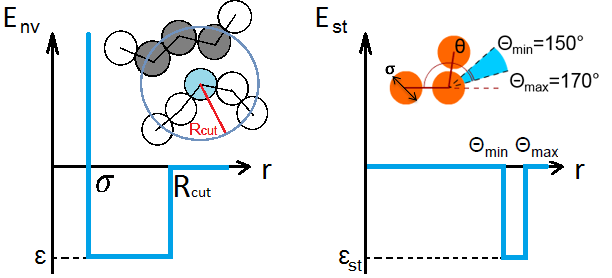
Figure 1. Non-valent square-well interaction potential (on the left) and stiffness square-well potential (on the